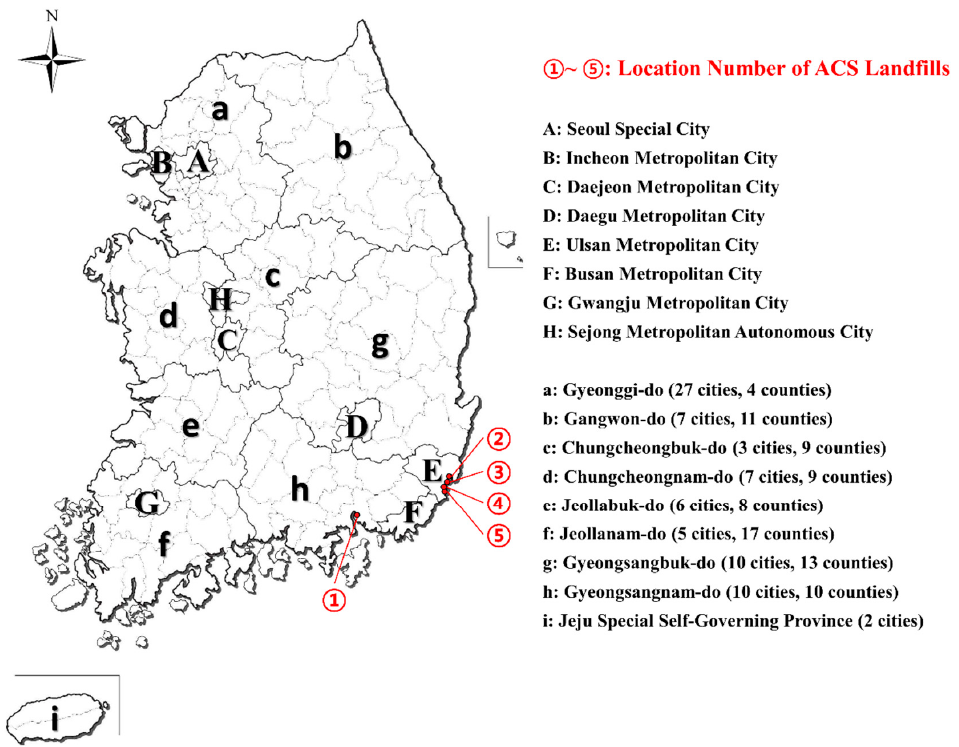
Figure 3. Local governing units of Korea. Metropolitan governing units (thick line, upper case), local governing units (thin line, lower case), and locations of ACS landfills are shown.